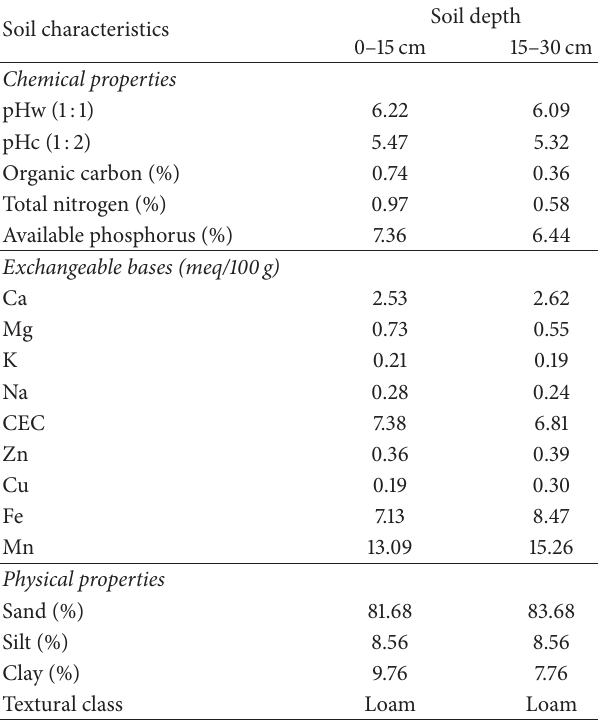
Table4:Physicalandchemicalpropertiesofsoiloftheexperimental site during 2010/2011.